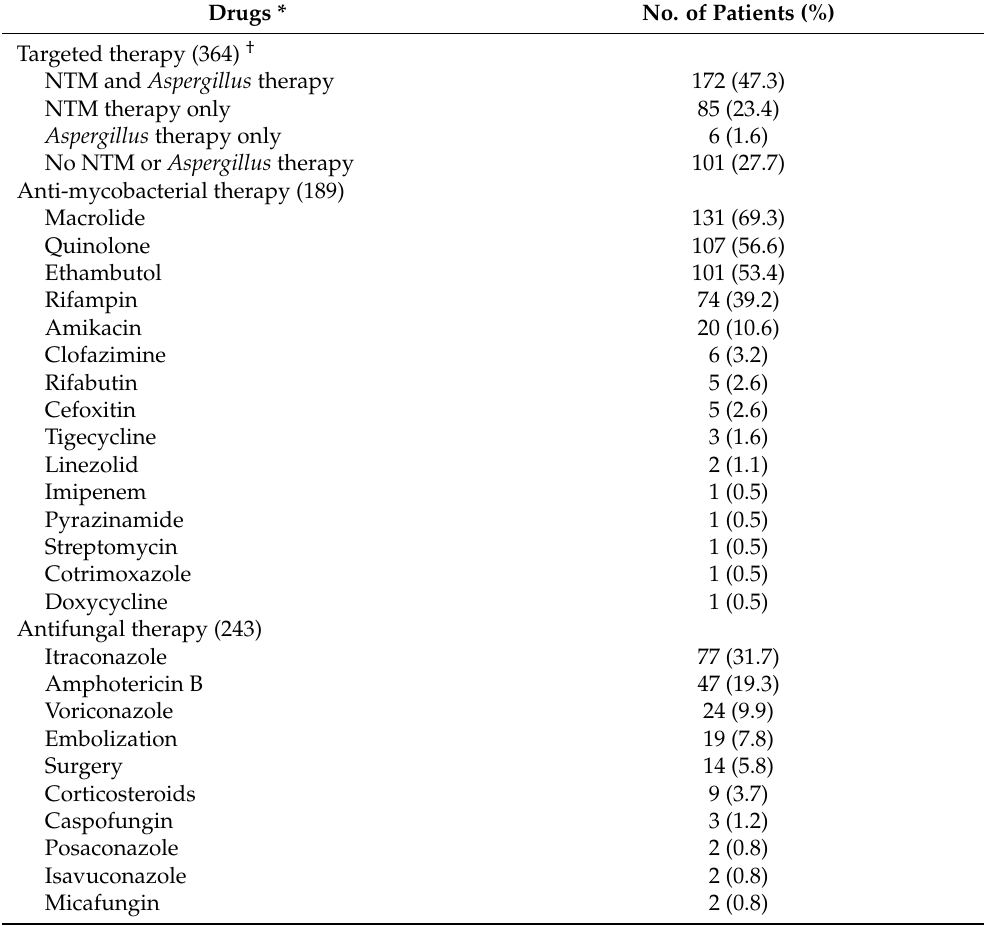
Table 4. Targeted therapy for NTM and/or Aspergillus in 364 patients. Drugs used in 189 patients who received anti-mycobacterial therapy and in 243 patients who received antifungal therapy. Drugs * No. of Patients